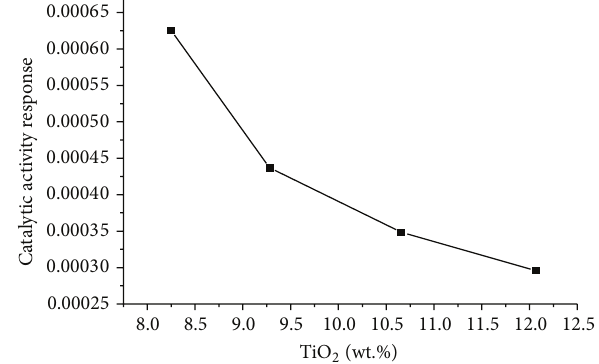
Figure 7: Effect of different wt.% of TiO 2 on catalytic activity response in series